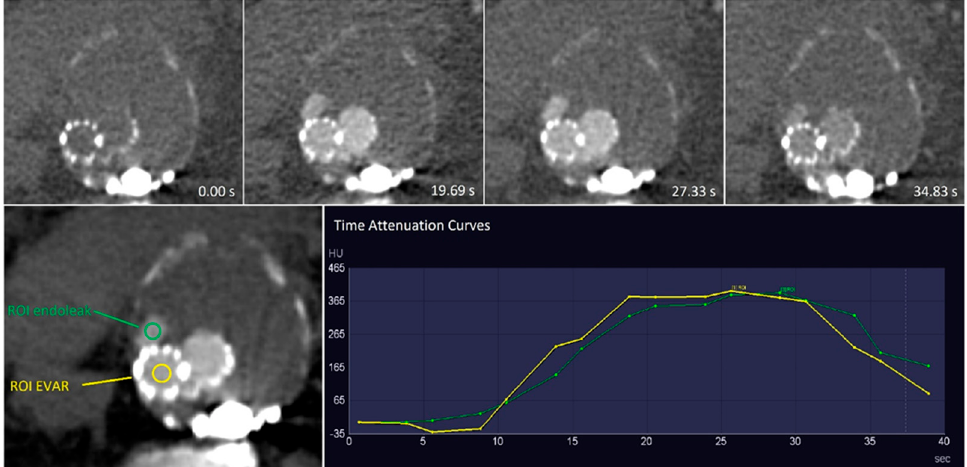
Figure 1. Example of the use of a region of interest (ROI) in a type IIIa endoleak. The images in the top row show different dynamic computed tomography angiography phases given in seconds. The ROI was used to determine the time attenuation curves of the endoprosthesis lumen and the endoleak by dynamic vessel evaluation combined with the time-to-peak of the endoprosthesis lumen and endoleak. Both curves were similar, and in combination with the location of the endoleak and the lack of component disconnection, this endoleak was defined as type IIIb.